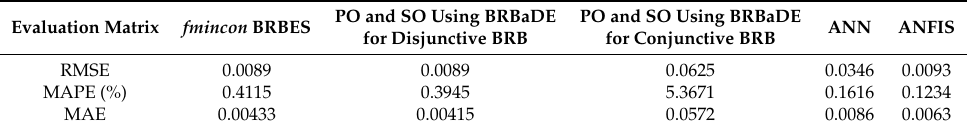
Table 7. Comparison of root mean square error (RMSE), mean absolute percentage error (MAPE), and mean absolute error (MAE) for different kinds of BRBES using PO and SO using BRBaDE, ANFIS, ANN, and the fmincon of testing datasets from